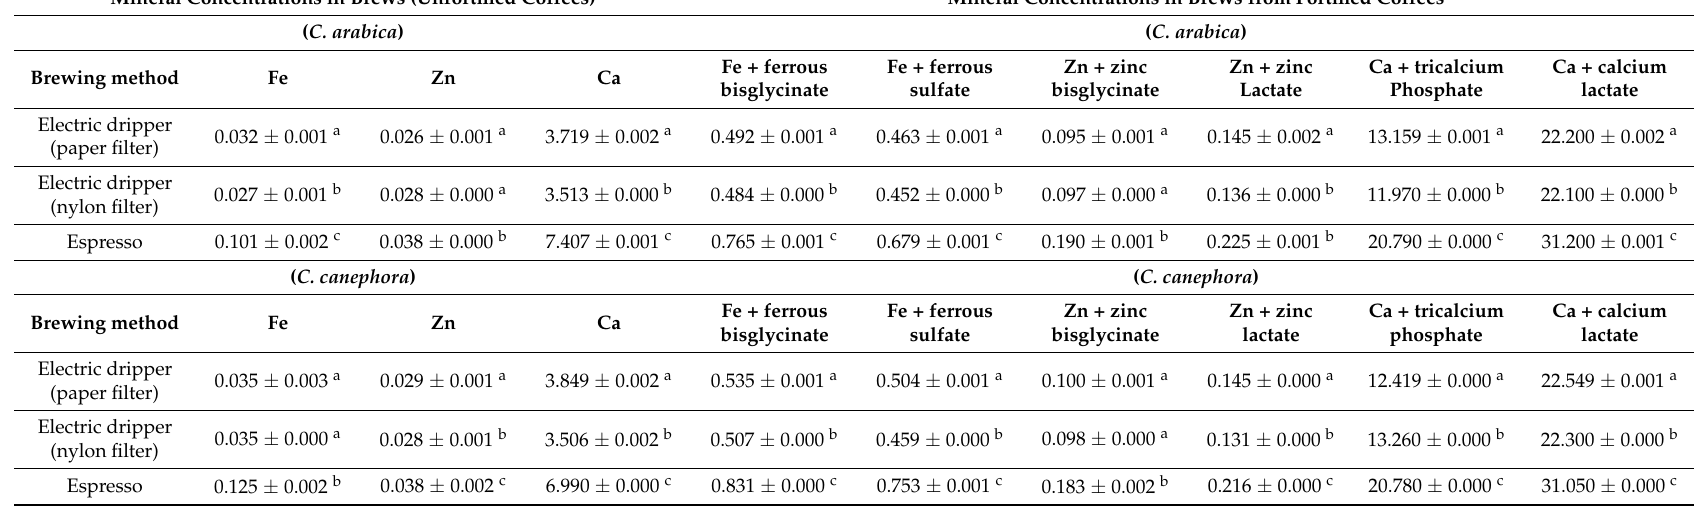
Table 3. Mean concentrations of iron, zinc and calcium in brews from ground roasted, unfortified (control), and fortified C. arabica and C. canephora coffee species (mg/100 mL) §